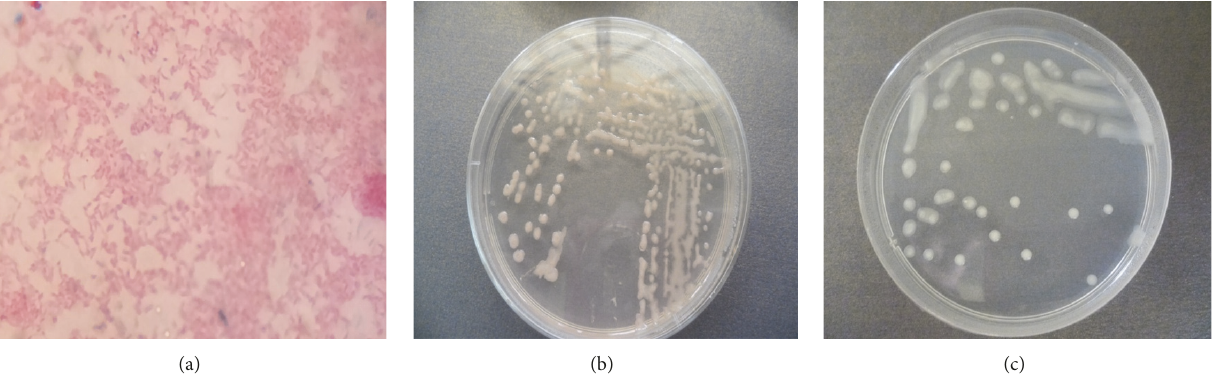
Figure 1: Gram-negative reaction and growth response of rhizobia isolates on YEMA medium containing Congo red. Gram-negative reaction of a fourteen-day-old rhizobia isolate (a); colonies of rhizobia isolate on YEMA media with Congo red (b) and without Congo red (c).